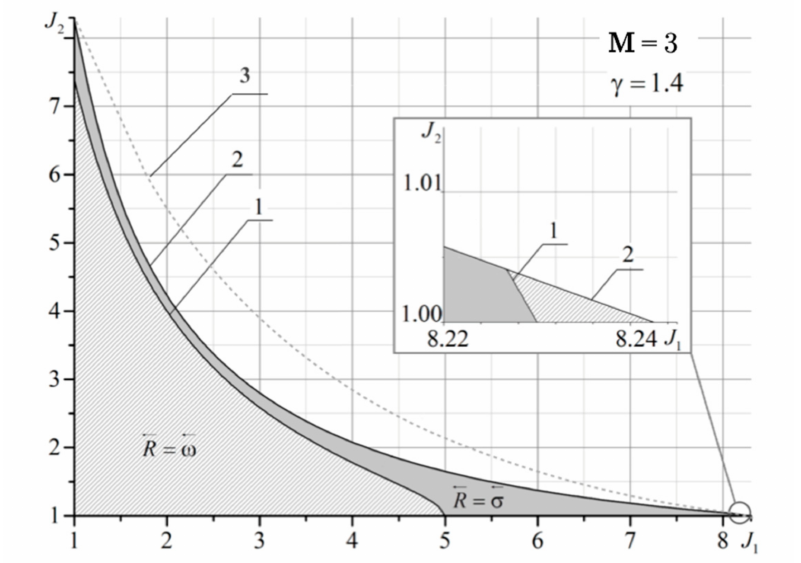
Figure 13. Domains of existence of various types of reflected discontinuity with regular interference of shock waves in the same direction. Line 1 corresponds to characteristic shock wave, line 2 corresponds to boundary of regular interference, and line 3 corresponds to sound intensity J s (M 2 = 1) of the second